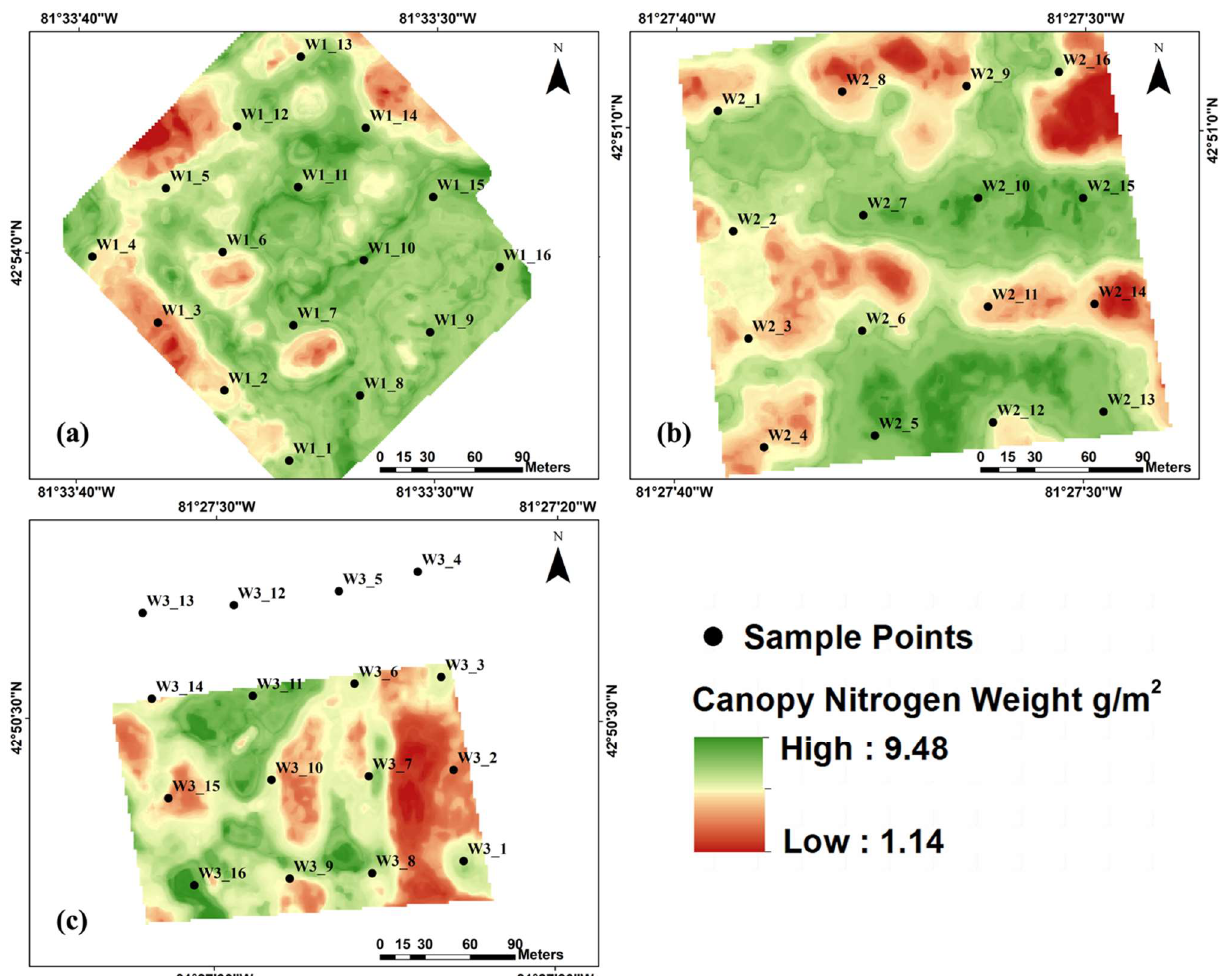
Figure 8. Satellite-based prediction maps of canopy nitrogen weight derived from top 17 variables in the 12, 20, and 27 May RF model for ( a ) W1, ( b ) W2, and ( c ) W3 wheat fields.